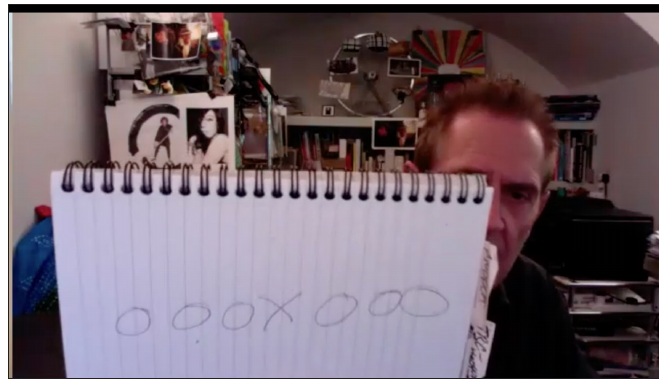
Figure 4: Dave Trott representing TV ads with O and X’s via